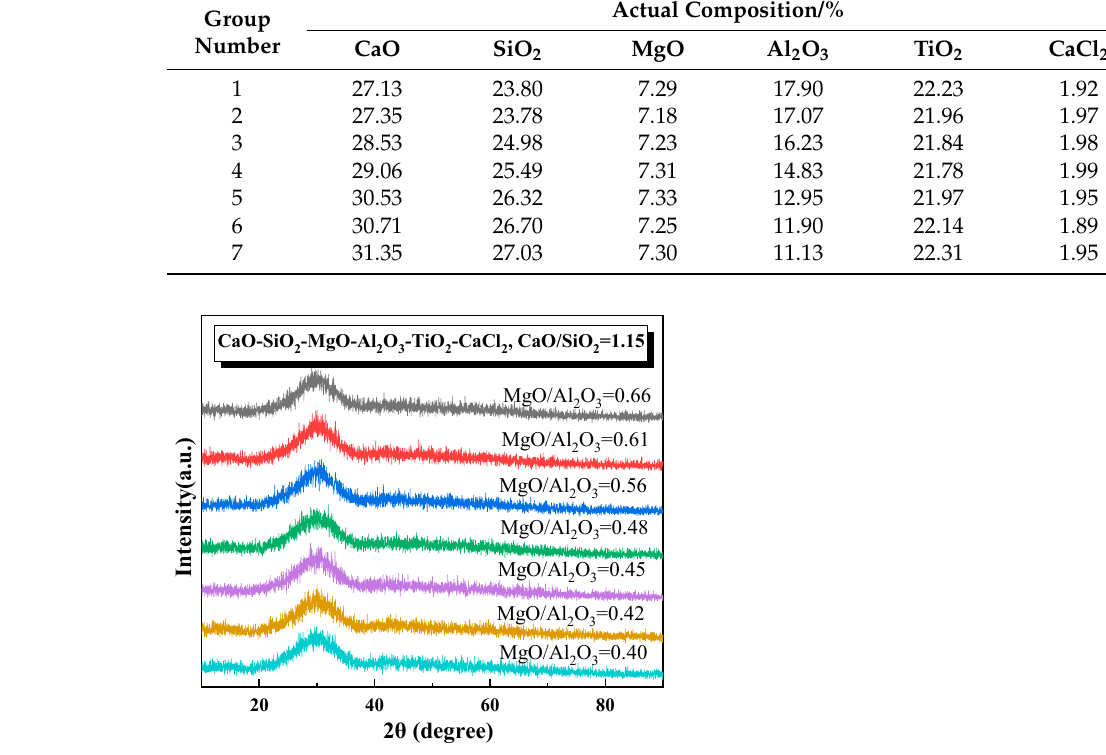
Figure 1. XRD curves of the quenched samples.